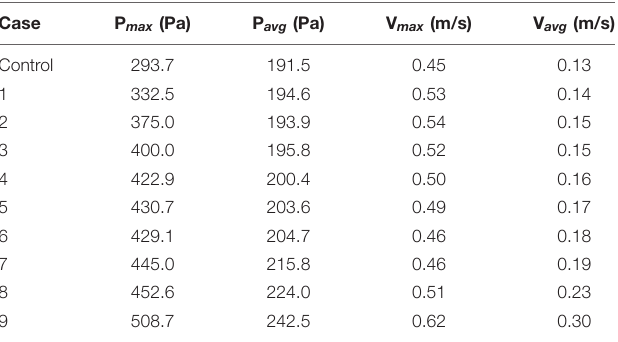
TABLE 2 | Quantitative values of wall pressure and velocity of the PTSJ with different compression